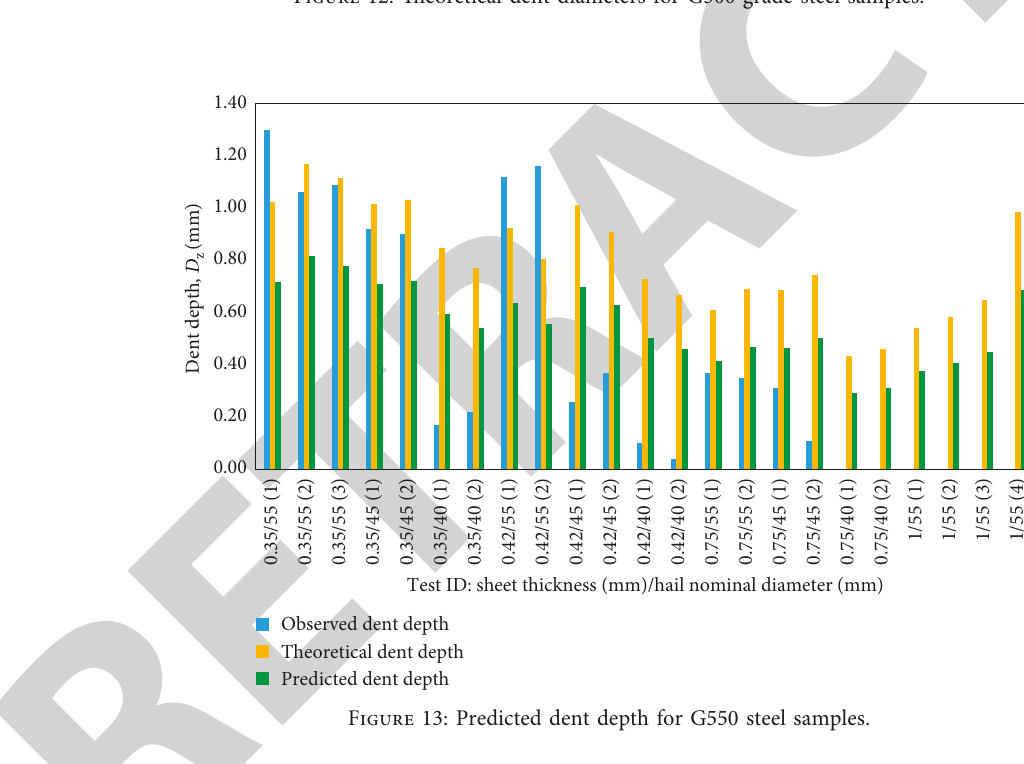
Figure 12: Theoretical dent diameters for G300 grade steel samples.